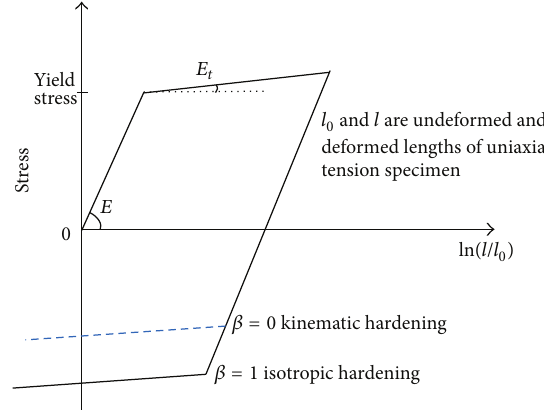
Figure 2: Plastic kinematic model for steel modeling.